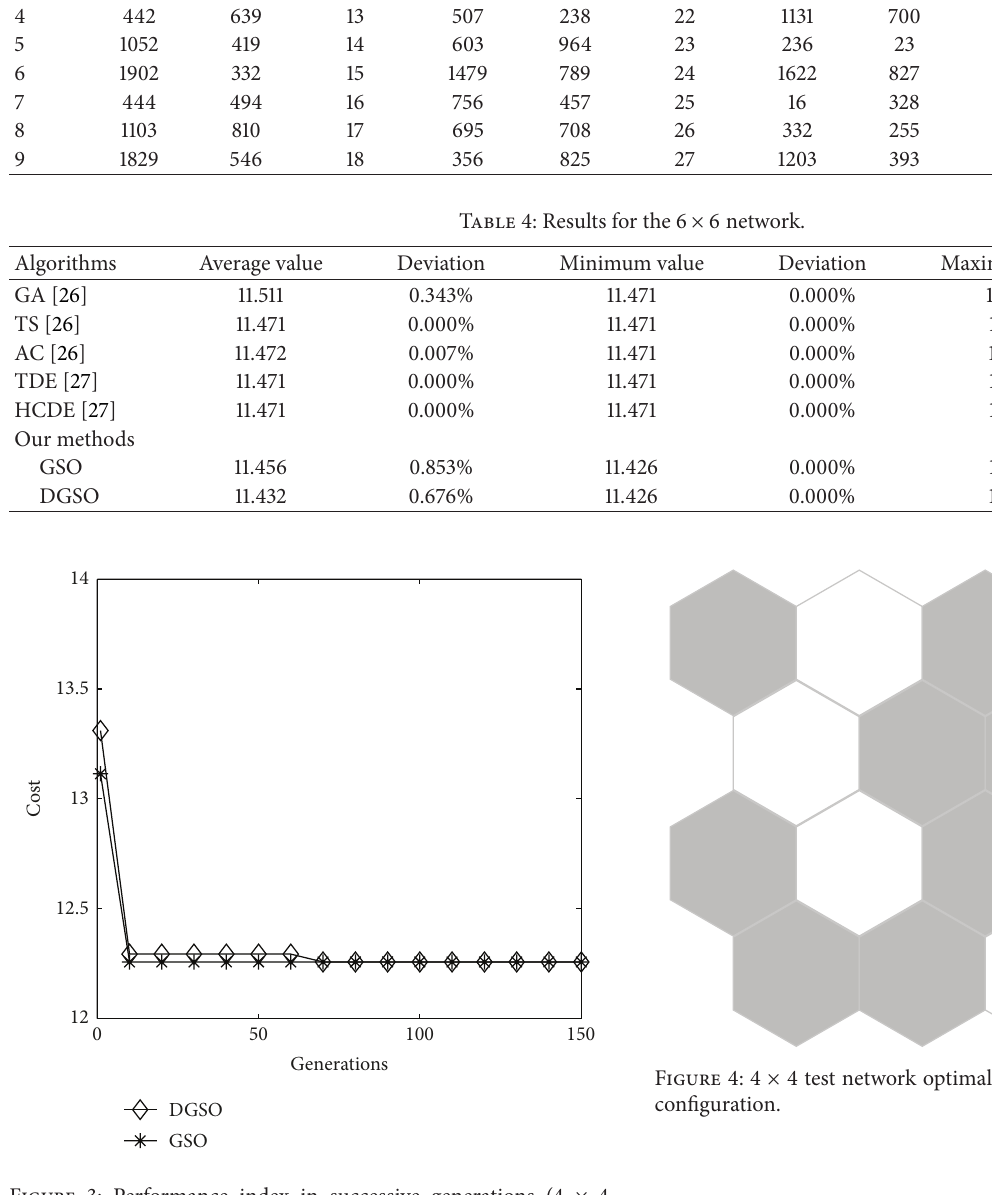
Figure 3: Performance index in successive generations ( 4 × 4 network).